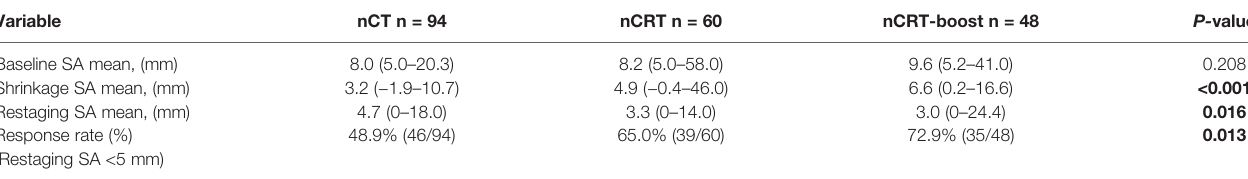
TABLE 2 | Baseline and restaging MRI values of LLN SA for patients treated by three different treatment regimens (n = 202). Variable nCT n = 94 Baseline SA mean,